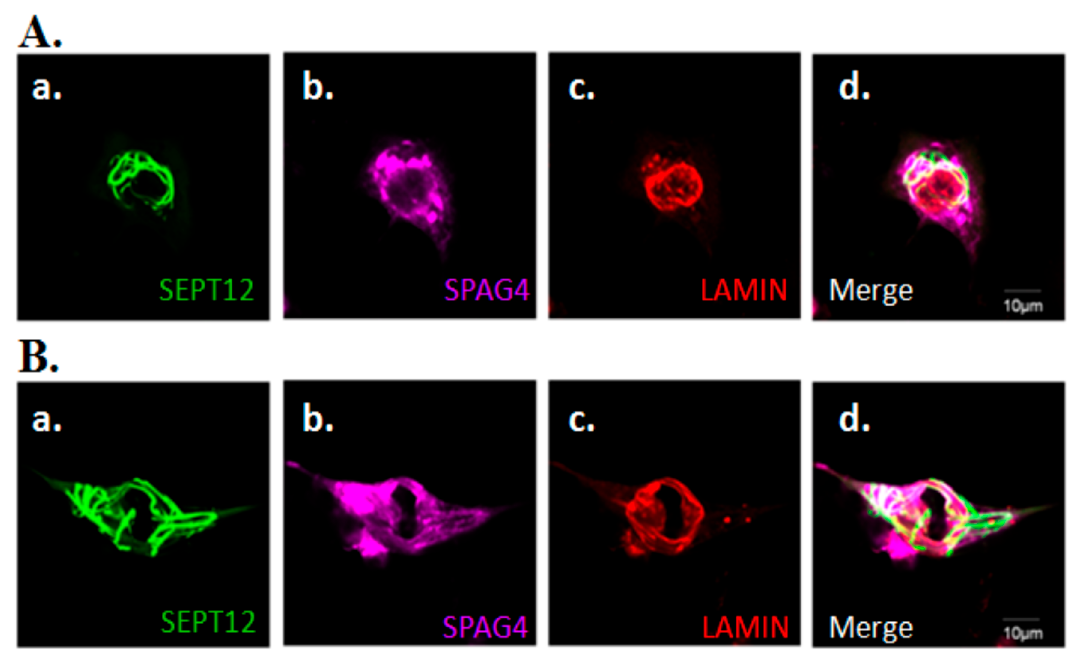
Figure 4. SEPT12 overexpression disturbs the morphology of the LAMIN in the NT2/D1 male germ cell line. SEPT12 signals are around NE ( A ) or cytoplasm ( B ). Immunofluorescence staining with the anti-LAMIN antibody in the NT2D1 cells cotransfected with the pEGFP-SEPTIN12 and pFLAG-SPAG4 vectors. (a) Anti-EGFP antibody (green), (b) anti-FLAG antibody (pink), (c) and anti-LAMIN antibody (red); (d) image obtained after merging the images in (a), (b), and (c). Scale bar: 10 μ m.